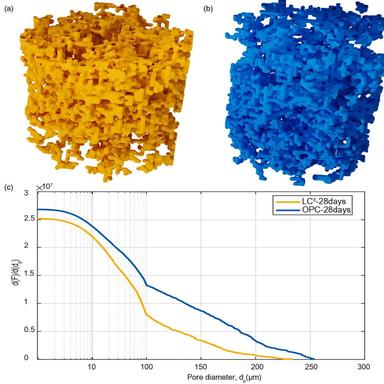
Virtualisation of reconstructed microstructure from the original micro-CT images of (a) LC3 and (b) OPC. (c) Pore size distribution of LC3 and OPC at 7 and 28 days from analysis based on micro-CT images.